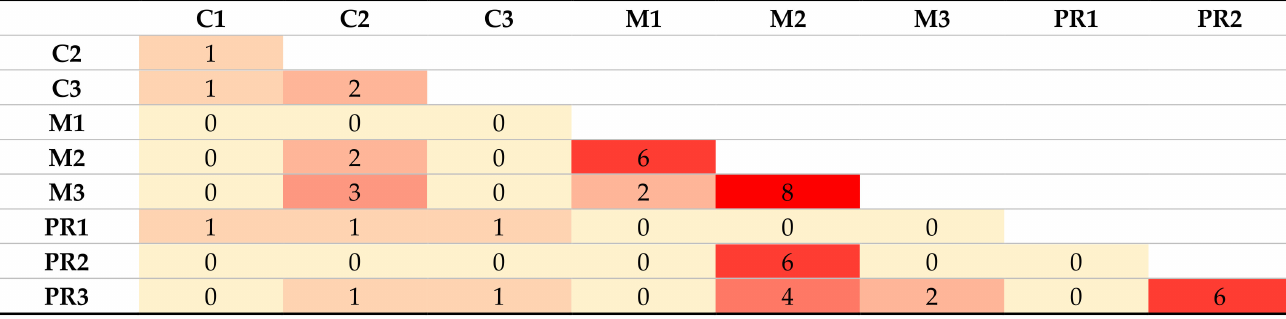
Figure 6. Interactions between two codes within the UK’s